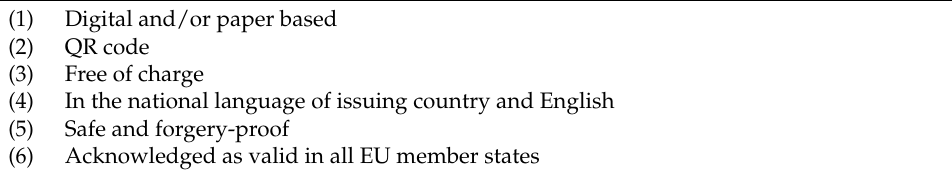
Table 1. Main characteristics of COVID